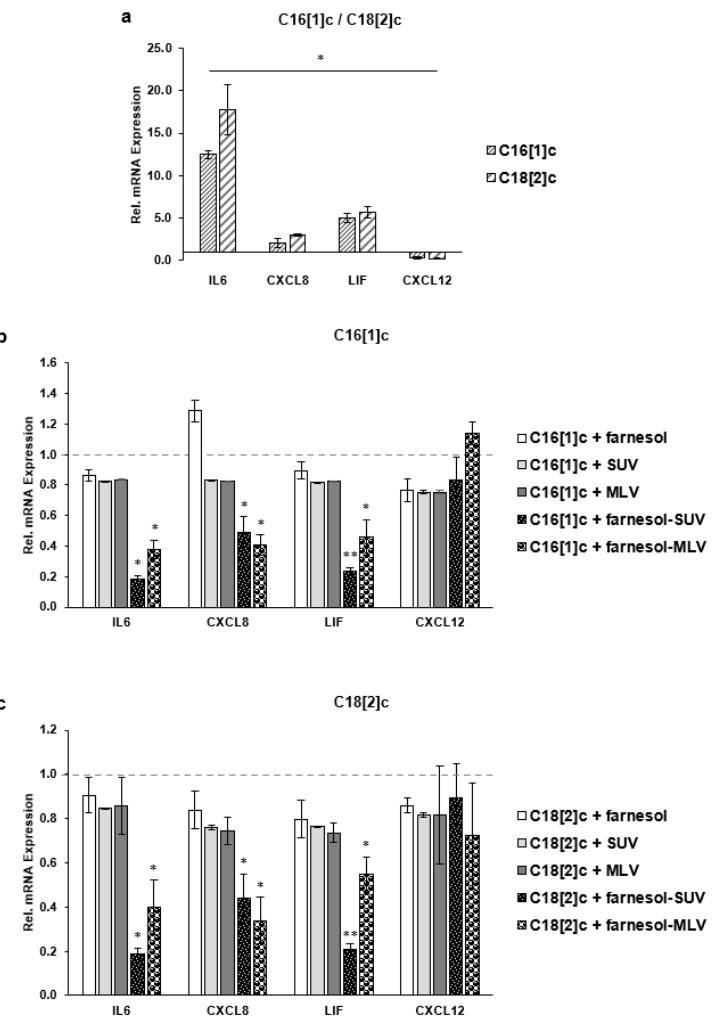
Figure 6. Farnesol inhibits the FFA-induced transcription of inflammatory genes. SkMs were left untreated or treated with farnesol, SUV, MLV, farnesol-SUV, or farnesol-MLV for 24 h; ( b ) SkMs were washed and treated with C16[1]c ( a , b ), C18[2]c ( a , c ) or left untreated for 24 h in three independent sets of experiments. SkM extracts were analyzed in triplicates using multiplex mRNA quantification to determine the expression level of IL6, CXCL8, LIF, and CXCL12 mRNAs normalized to the level of GAPDH and GUSB mRNAs. To obtain the relative FA-mediated activation of expression, the expression of each marker mRNA in FA-treated cells was compared to its expression level in untreated cells (Figure 6a). To obtain the relative inhibition by farnesol, the expression of each marker mRNA in farnesol- or liposomes-treated cells was compared to its expression in C16[1]c-treated (Figure 6b) or C18[2]c-treated cells (Figure 6c).Thus, the expression level in untreated control cells (Figure 6a), C16[1]c-treated cells (Figure 6b), or C18[2]c-treated cells (Figure 6c) was set to 1 (dashed gray line). The results are presented as the mean ± SD of the relative expression of designated markers in three independent experiments (white bars). Statistical significance was calculated using one-way ANOVA with Bonferroni’s multiple comparison test. p ≤ 0.05 (*). p ≤ 0.01 (**).